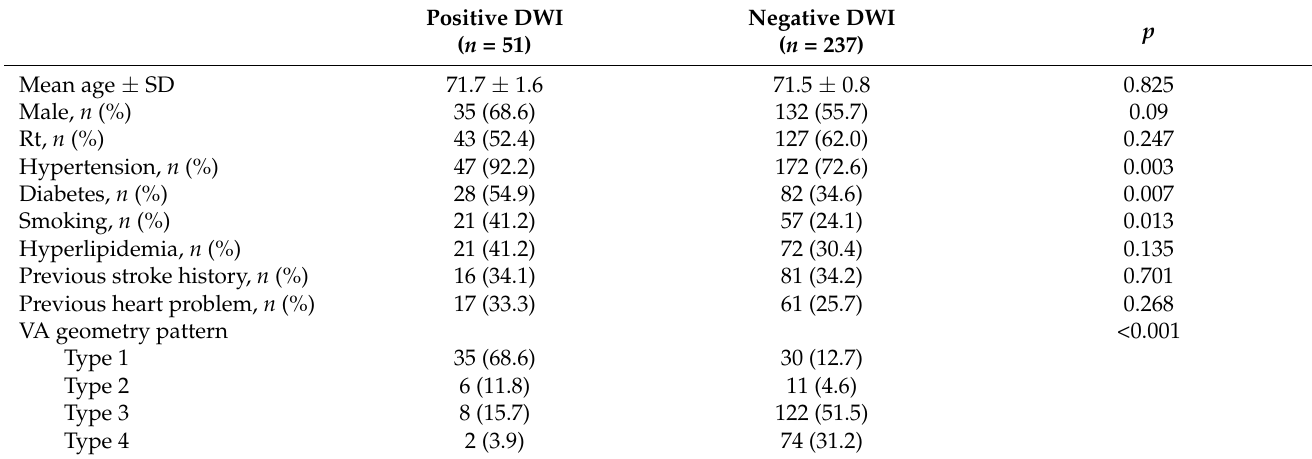
Table 3. Comparison between positive DWI findings and negative DWI findings in this